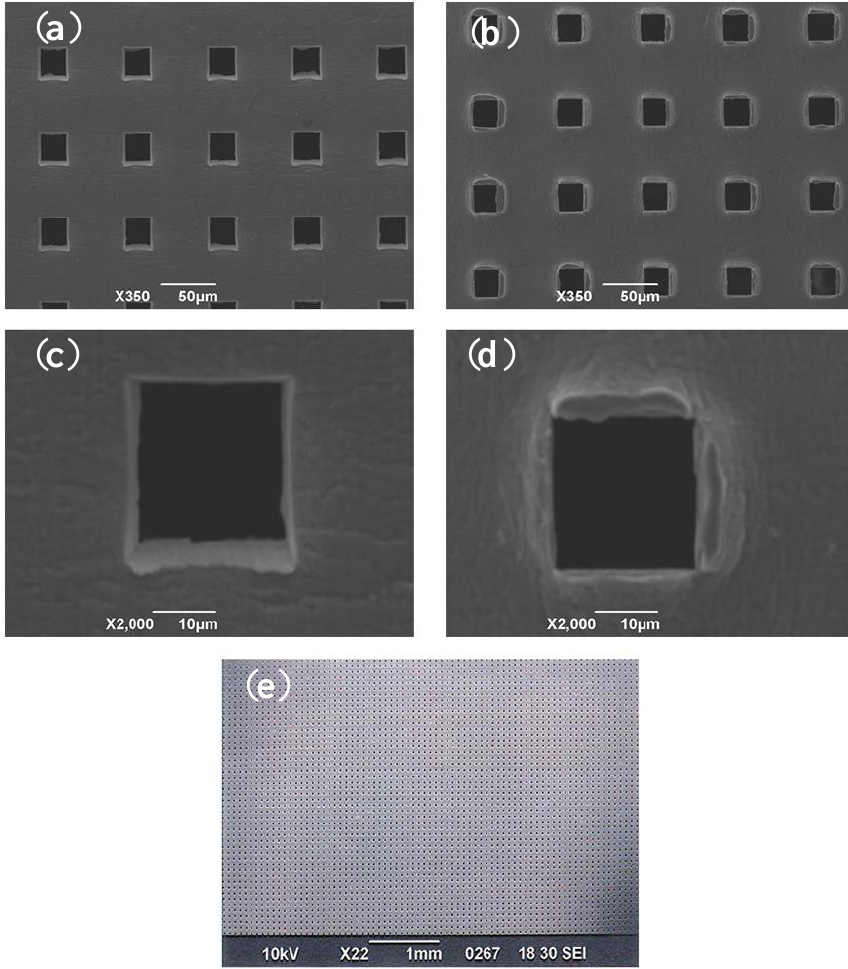
Figure 3. Surface structures of cell–free microperforated Ti templates using SEM. ( a ) An overview of 25 × 25 μm square pores, called the head side (scale bar represents 50 μm). ( b ) An overview of the tail side (scale bar represents 50 μm). ( c ) A higher magnification view of a pore on the head side (scale bar represents 10 μm). ( d ) A higher magnification view of the tail side (scale bar represents 10 μm). ( e ) A wide view of the template (scale bar represents 1 mm).